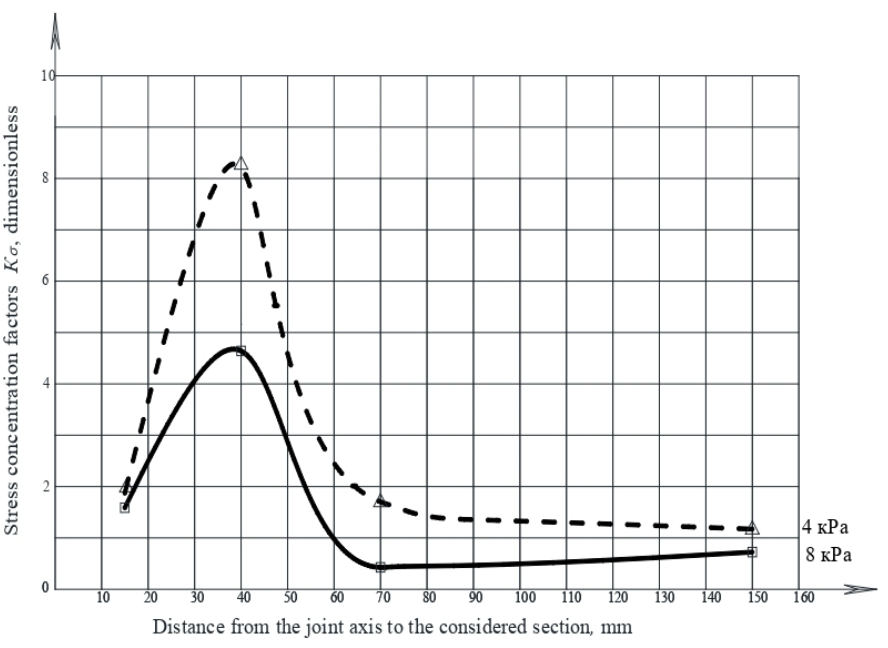
Figure 8. The hoop stress concentration in the field joint zone of the wall, with a bend of 30 mm in section C-3.